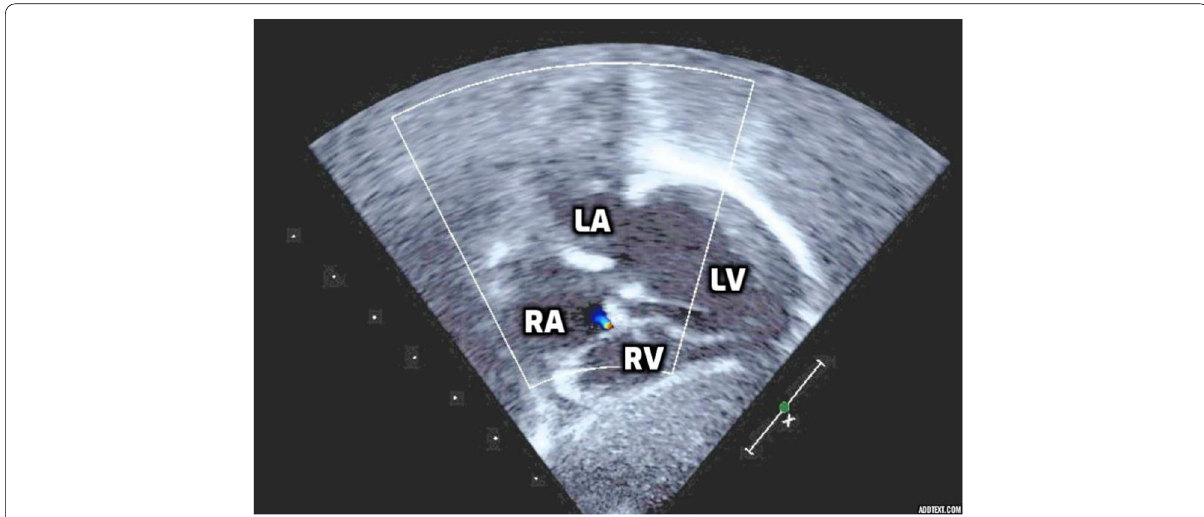
Fig. 4 Postoperative echocardiogram showing no residual septal defect and trivial atrioventricular valve regurgitation. RA Right Ventricular, LA Left Atrium, LV Left = =